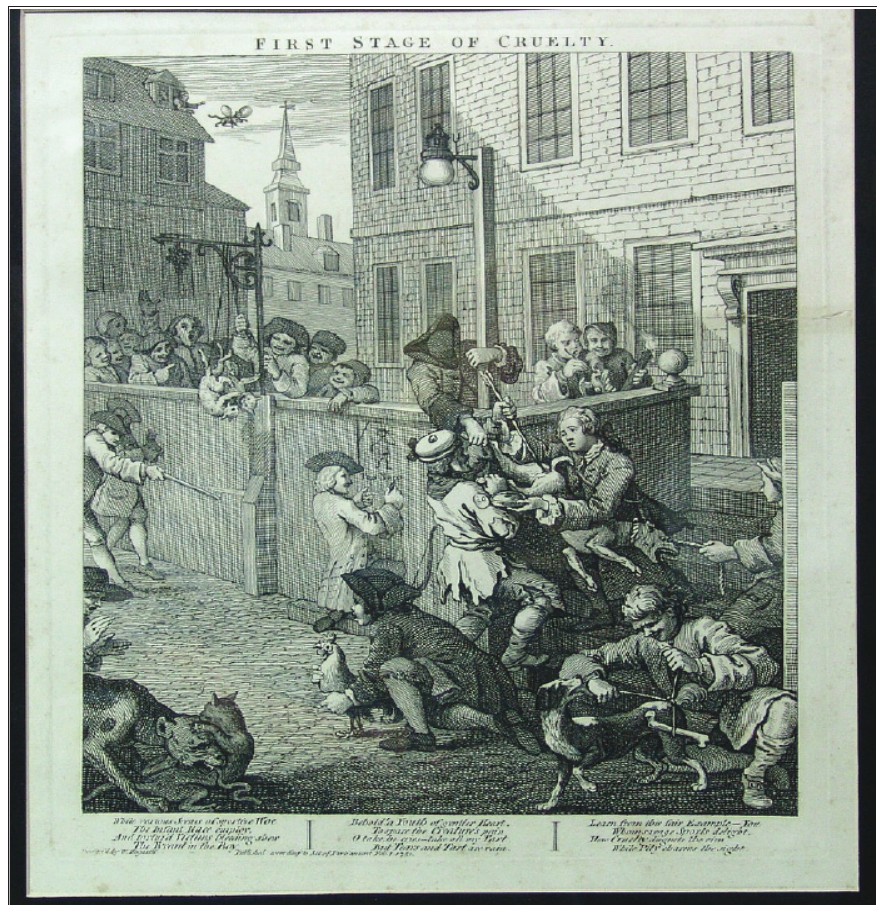
Figure 1: First Stage of Cruelty, William Hogarth